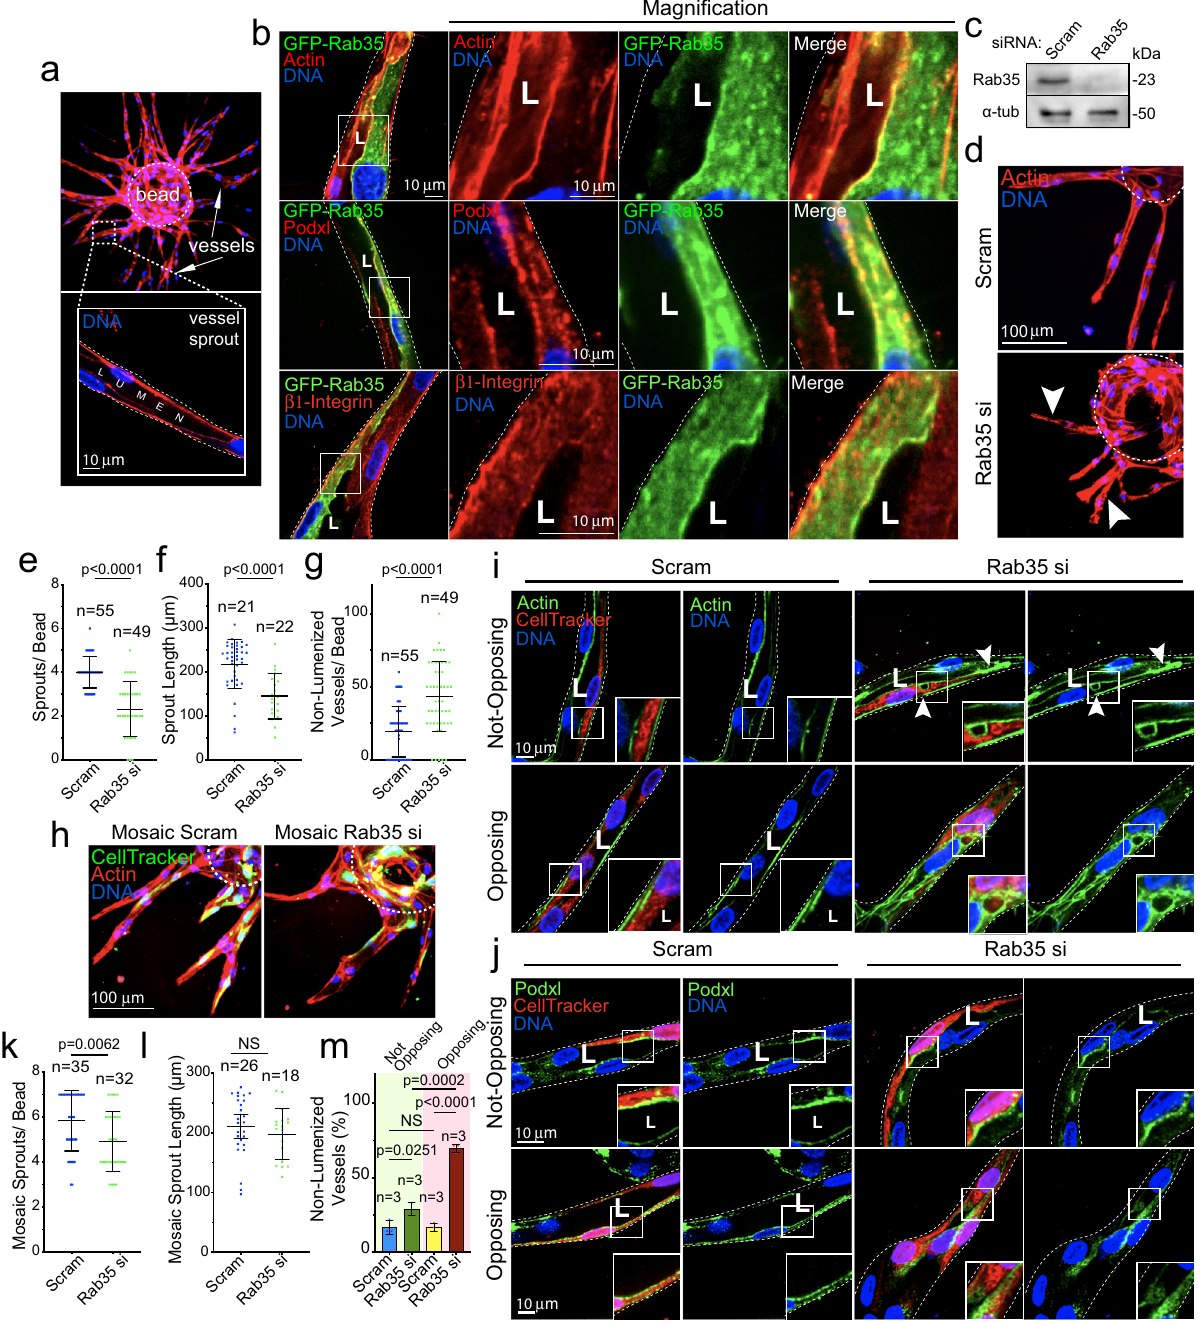
Fig. 1 | Rab35 is an apical membrane protein required for sprout formation. a Representative images of the fi brin-bead assay (FBA) at low and high magni fi ca- tion. Arrows mark sprout structures. Inset depicts lumenized sprout. b GFP-Rab35 localization in endothelial sprouts with actin (top panels), podocalyxin (Podxl, middle panels), and β 1-integrin (bottom panels). c Western blot con fi rmation of siRNA (si) knockdown (KD) of Rab35 (average 72.5% KD relative to control, n =3). d Representative image of scramble (Scram) control and Rab35 siRNA KD sprouts. Arrowheads denote short and non-lumenized sprouts. Dashed lines outline the microbead. e – g Graphs of indicated sprouting parameters between groups. n = number of sprouts. Error bars represent standard deviation, middle bars are the mean. h Representative images of sprout morphology of mosaic Scram and Rab35 KD cells, green indicates cell tracker of siRNA treated cells. i , j Representative